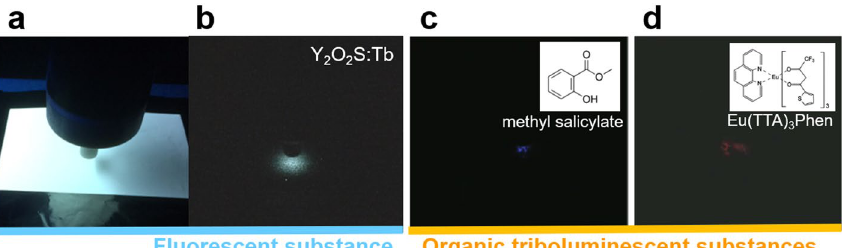
Figure 2. Light emission when luminescent substances was irradiated with corona discharge. ( a ) State of an experiment when the sample was irradiated with corona discharge. ( b ) White light observed in Y 2 O 2 S:Tb, which is a fluorescent substance. ( c , d ) Blue light and Red light observed in methyl salicylate and Eu(TTA) 3 Phen, which are an organic triboluminescent